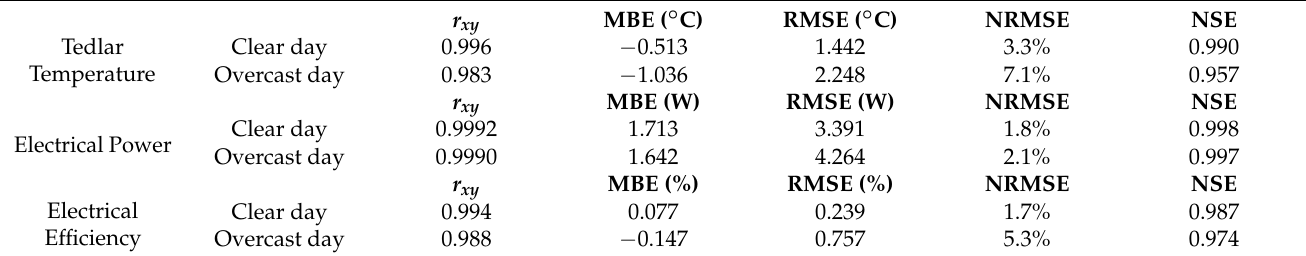
Table 3. Experimental validation indices for summer conditions.